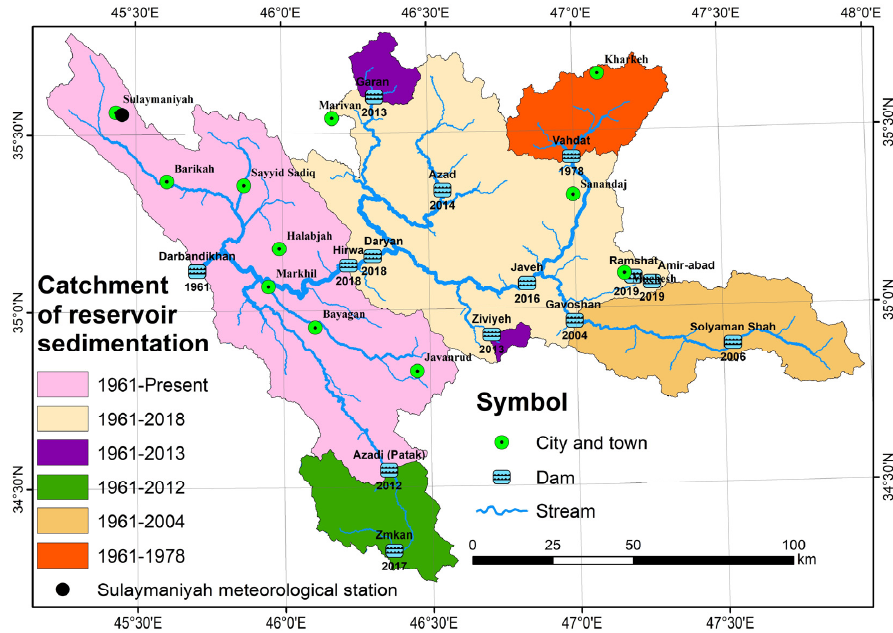
Figure 2. Changing the area of the catchment area of the stream sediments for the Darbandikhan dam over time. Table 2. Variation of the area of the Darbandikhan Dam catchment from 1961 to